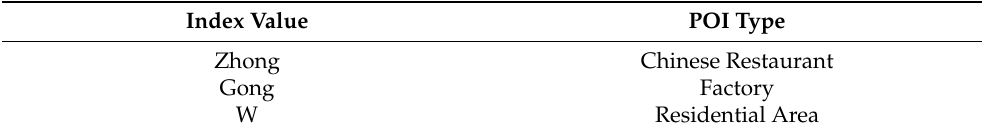
Table 3. Example entries in the index